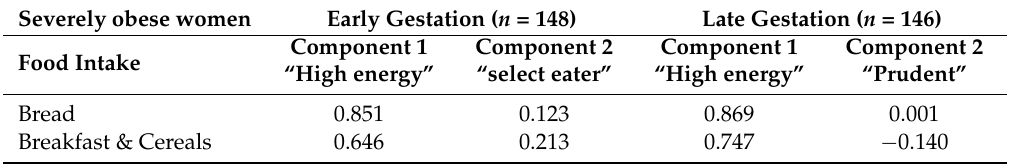
Table 6. Patterns of food intake in very severely obese women in early and late pregnancy. Severely obese